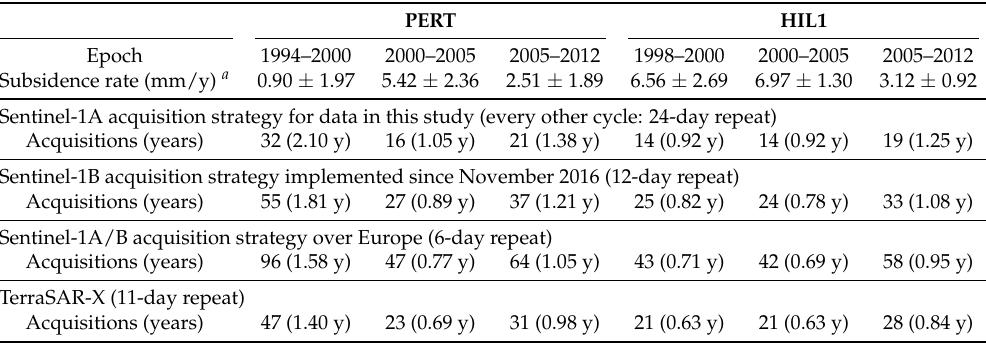
Table 1. Number of satellite acquisitions and corresponding period of time required to measure past vertical deformation rates at continuous GPS stations PERT and HIL1 not accounting for seasonal effects. PERT